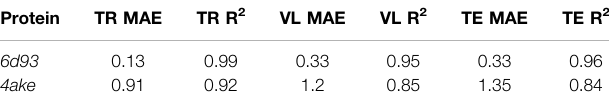
TABLE 5 | Results of the machine learning model in predicting the mapping entropy on the training (TR), validation (VL), and test (TE) sets for the two analyzed proteins. We display both the R 2 score and the mean average error (MAE, kJ/mol/K). Protein TR